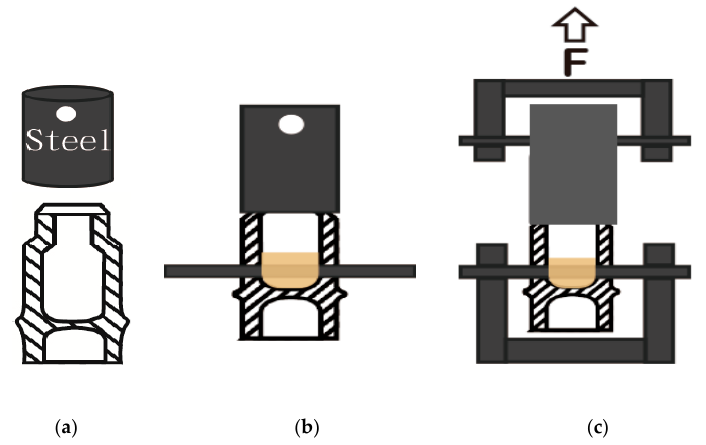
Figure 3. ( a ) Reduced bamboo and steel sleeve. ( b ) Steel joint. ( c ) Pullout test set-up.